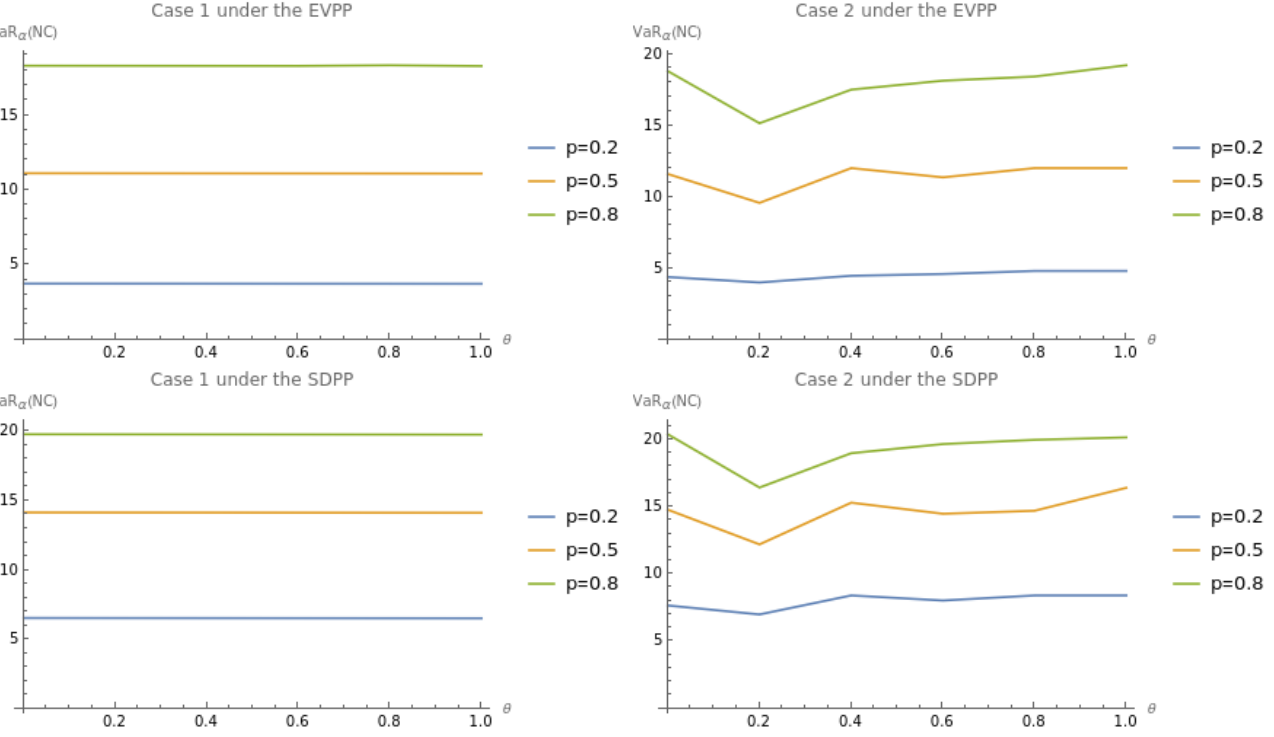
Figure 4. Effects of θ and p on VaR α ( NC; c ∗ , d ∗ , υ ∗ ) for Case 1 and Case 2 under the EVPP and SDPP when α = 0.950 is